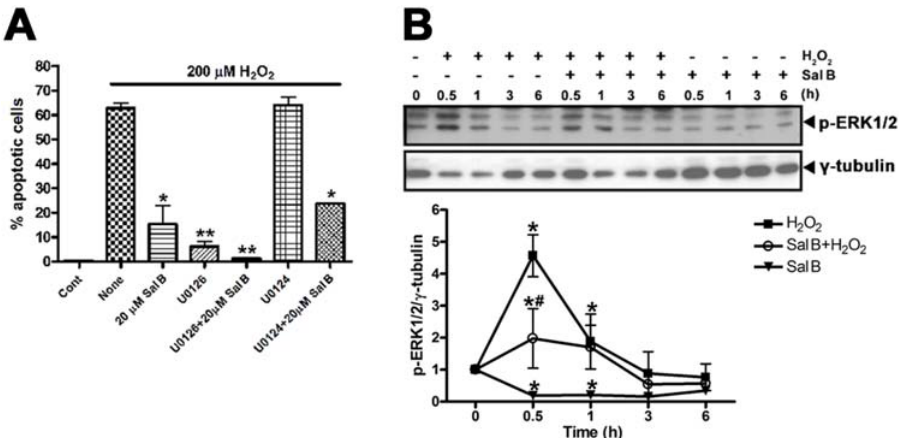
Figure 2. Effects of Sal B on MEK/ERK signaling. (A) Effects of Sal B, MEK inhibition, or their combination on H 2 O 2 -induced apoptosis. rCMECs were incubated with U0126 (10 m M) or U0124 (10 m M) for 1 h and then exposed to H 2 O 2 in the presence or absence of Sal B pretreatment for 12 h. * P , 0.05; ** P , 0.01 versus H 2 O 2 alone. Data are representative of three independent experiments. (B) Time course of phosphorylated ERK1/2 expression in rCMECs incubated with H 2 O 2 (200 m M) alone, or with H 2 O 2 (200 m M) and Sal B (20 m M), or with Sal B (20 m M) alone. Immunoblotting were carried out on cell lysate proteins from control cells or rCMECs pretreated with Sal B for 1 h and then exposed to H 2 O 2 for the indicated times. The representative Western blots and the quantitative analysis of protein expression (in relative protein density units). * P , 0.05 versus control, # , P , 0.05 versus H 2 O 2 alone. Data are representative of three independent experiments.